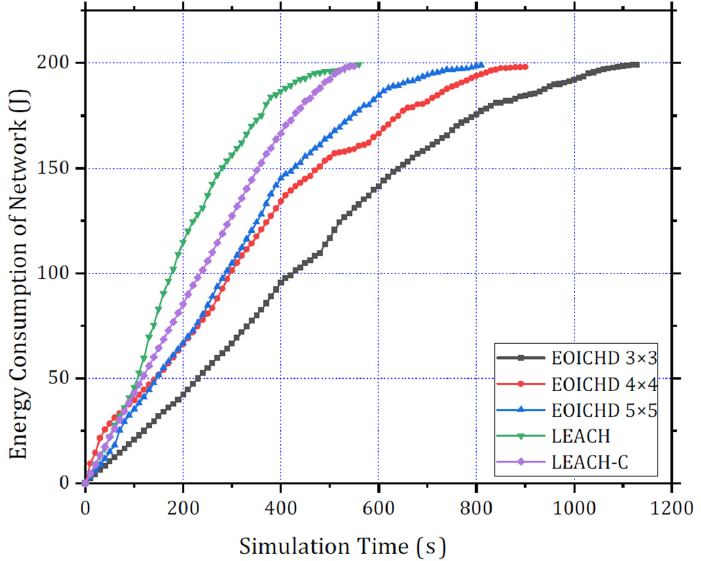
Figure 9. Energy consumption of network over simulation period Scenario